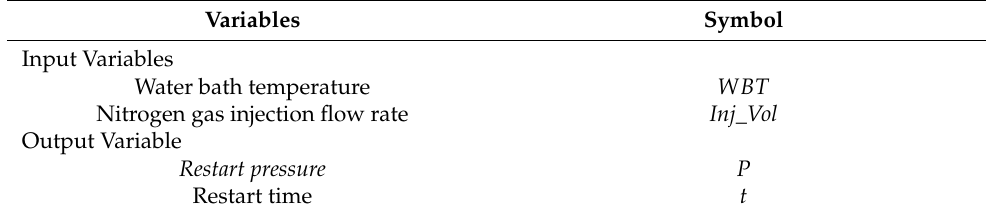
Table 3. Artificial Neural Network (ANN) input and output